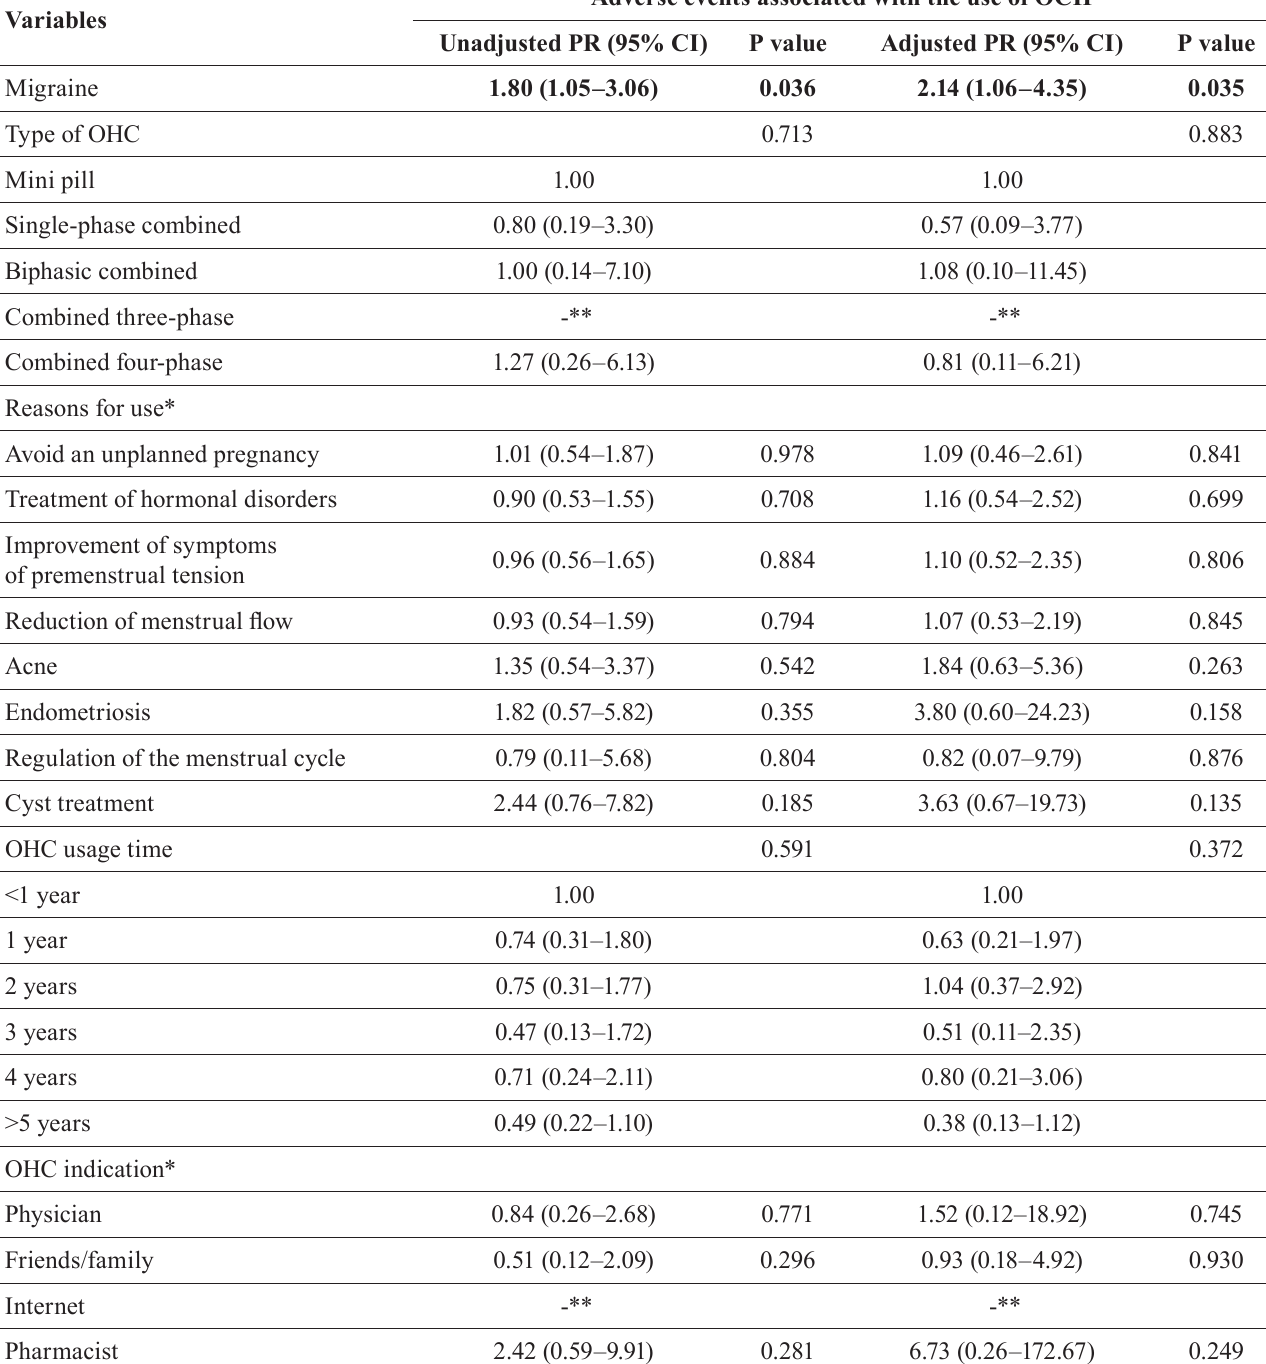
TABLE V - U nadjusted and adjusted prevalence ratios (PR) with 95% confidence intervals (95% CI) for the occurrence of adverse events among pharmacy students who used oral hormonal contraceptives (n =